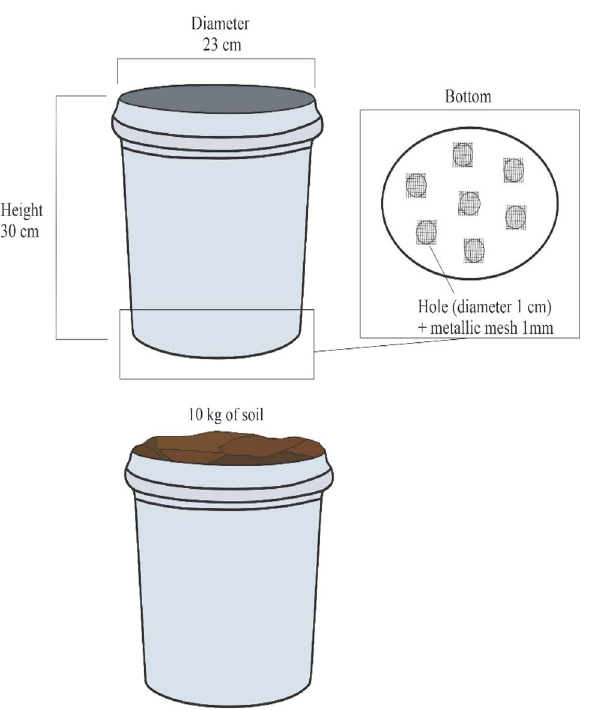
Figure 5. Bucket plastic bucket details for dung beetle